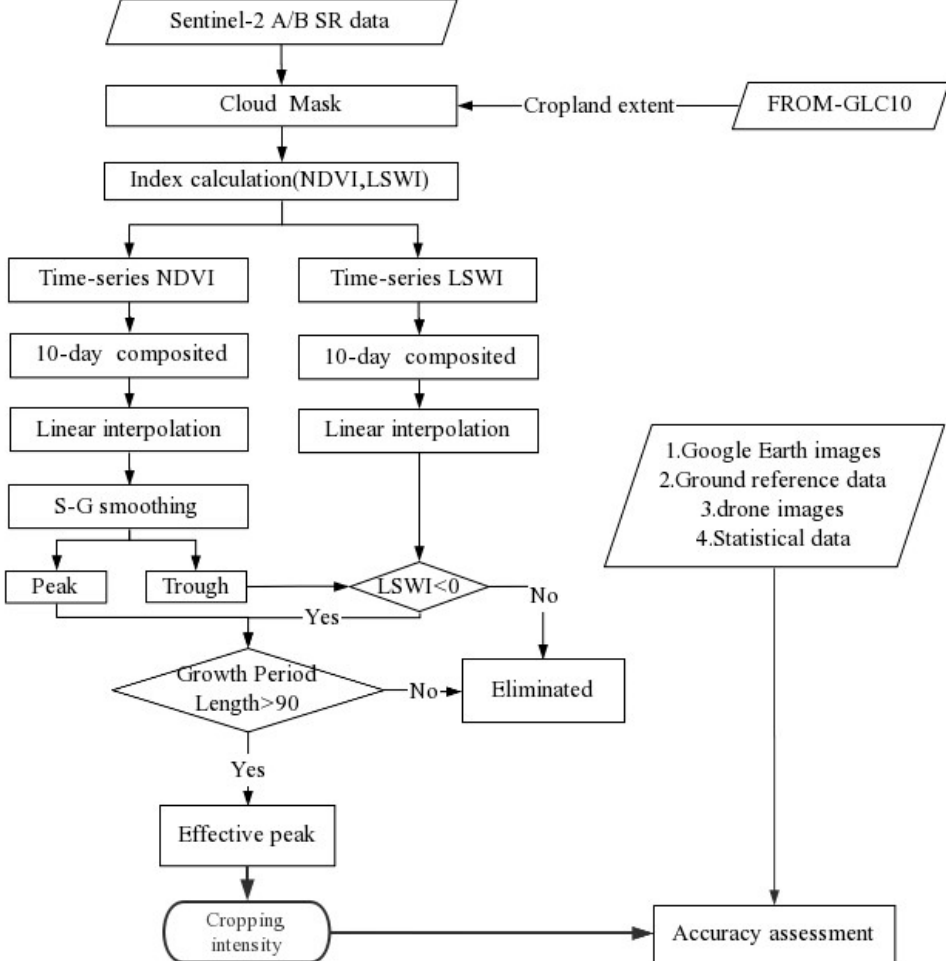
Figure 4. Flowchart of the overall approach for mapping the cropping Figure 4 . Flowchart of the overall approach for mapping the c ropping intensity.